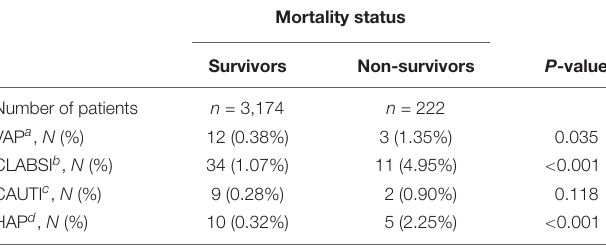
TABLE 2 | Complications during pediatric intensive care unit admission according to mortality. Mortality status Survivors